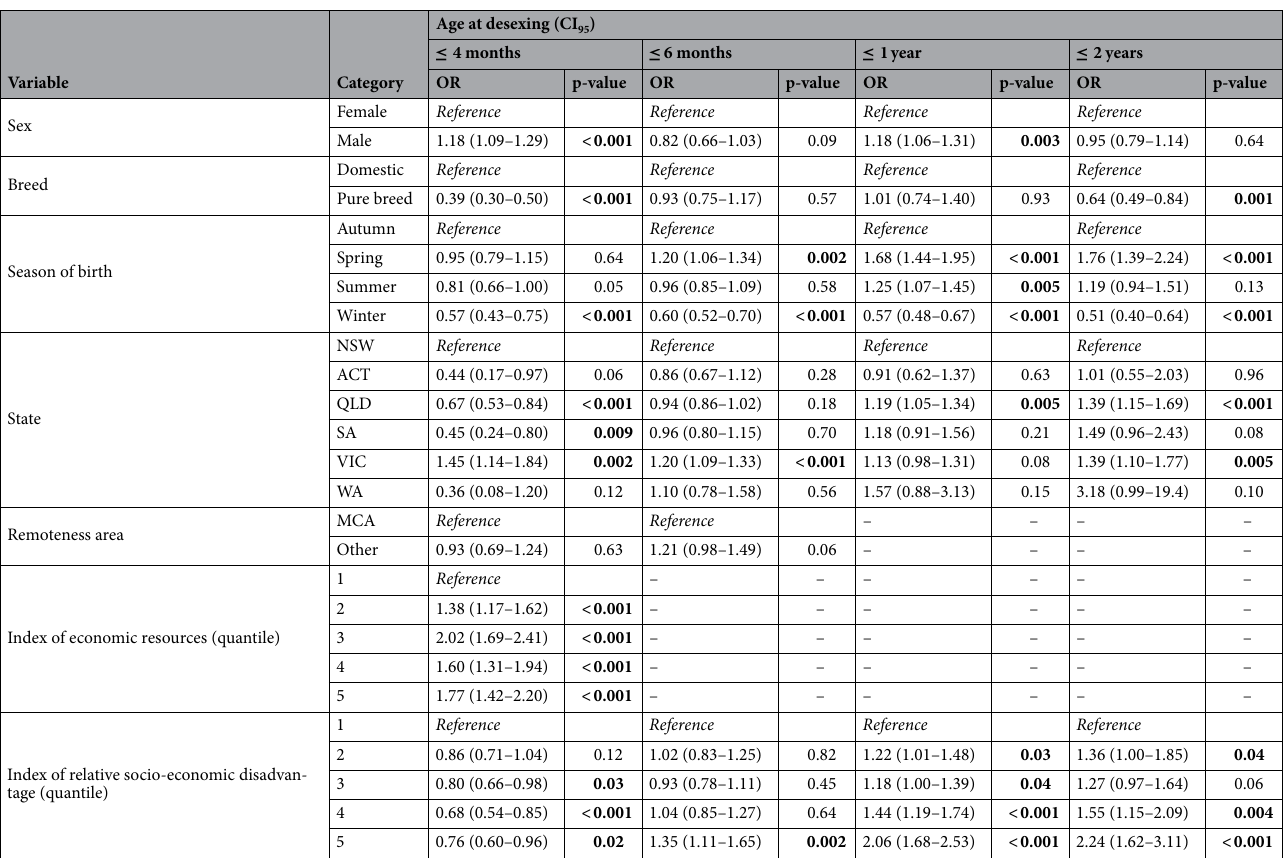
Table 3. Variables significantly associated with age at desexing using a multivariable logistic regression model in an Australia cat cohort born 2010–2017 inclusive. Significant values ( p < 0.05) are indicated in bold. CI confidence interval, MCA major cities of Australia.